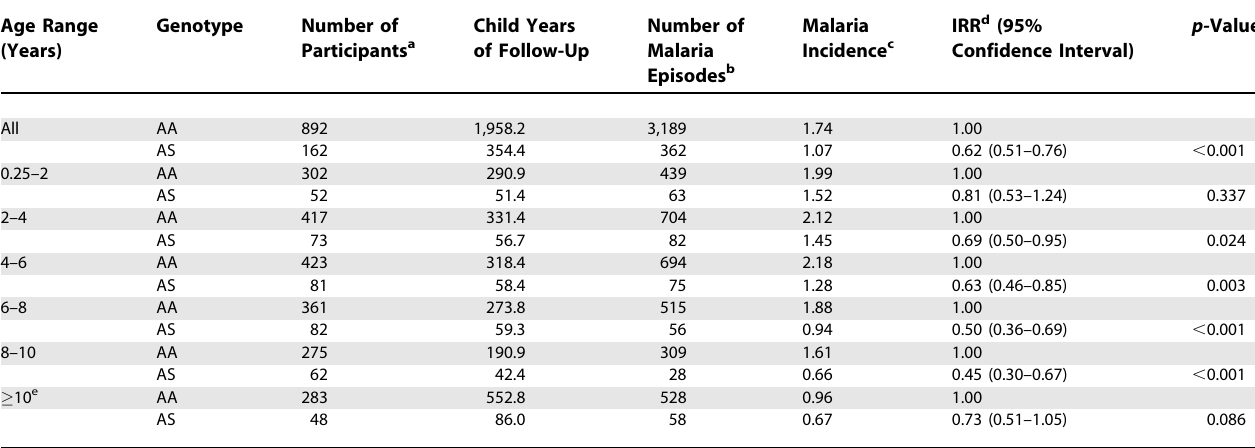
Table 1. Incidence of Clinical Malaria by Age and Haemoglobin Type Age Range (Years)